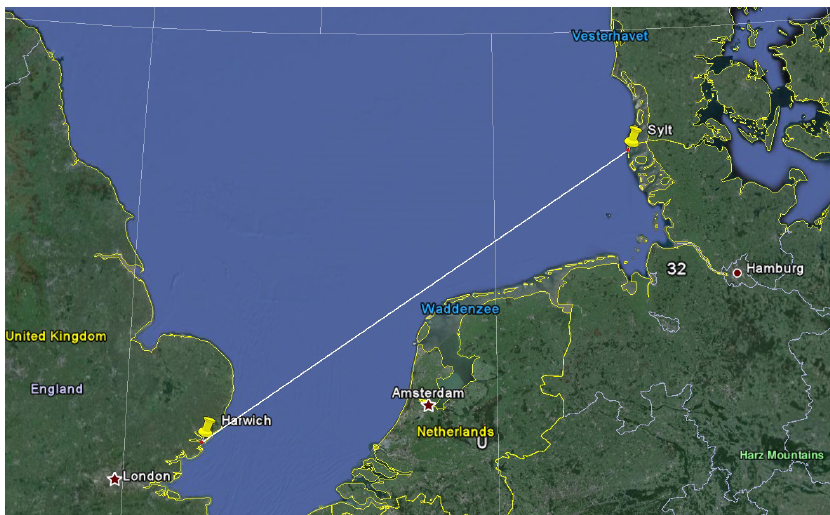
Figure 1. Loran-C propagation path between Sylt and Harwich (image from Google ™ Earth).